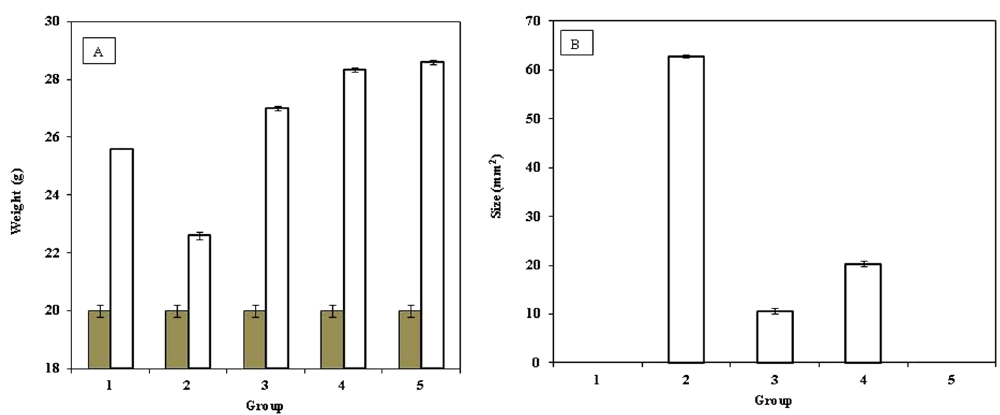
Figure 14. Effect of ASNPs on the: ( A ) mice’s weight as weight of the animal before the start of experiment ■ and at end of treatment □ and ( B ) tumor size in chemically induced murine tumor by 4T1 cells in BALB/c, the results are expressed as the mean ± error bar. Group 1 was untreated mice as control (without 4T1 cells and ASNPs injection), Group 2 was treated only by 4T1 cells, Group 3 was treated by 4T1 cells and after 7 days, when primary tumors reached a mean diameter of 3–4 mm, they were treated by ASNPs, Group 4 was treated by 4T1 cells and ASNPs simultaneously, Group 2 was treated only by